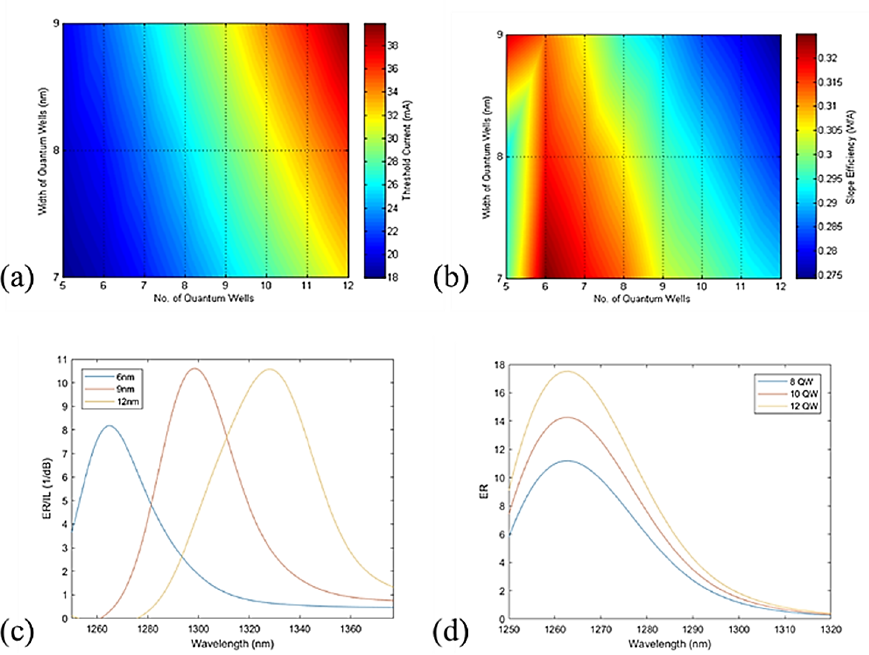
Figure 5. Quantum well width and number vs. ( a ) Fabry Perót (FP) Laser Threshold ( b ) FP slope effi- ciency. ( c ) Quantum well width vs. Extinction Ratio (ER) divided by Insertion Loss (IL) ( d ) Quantum well number vs. ER.